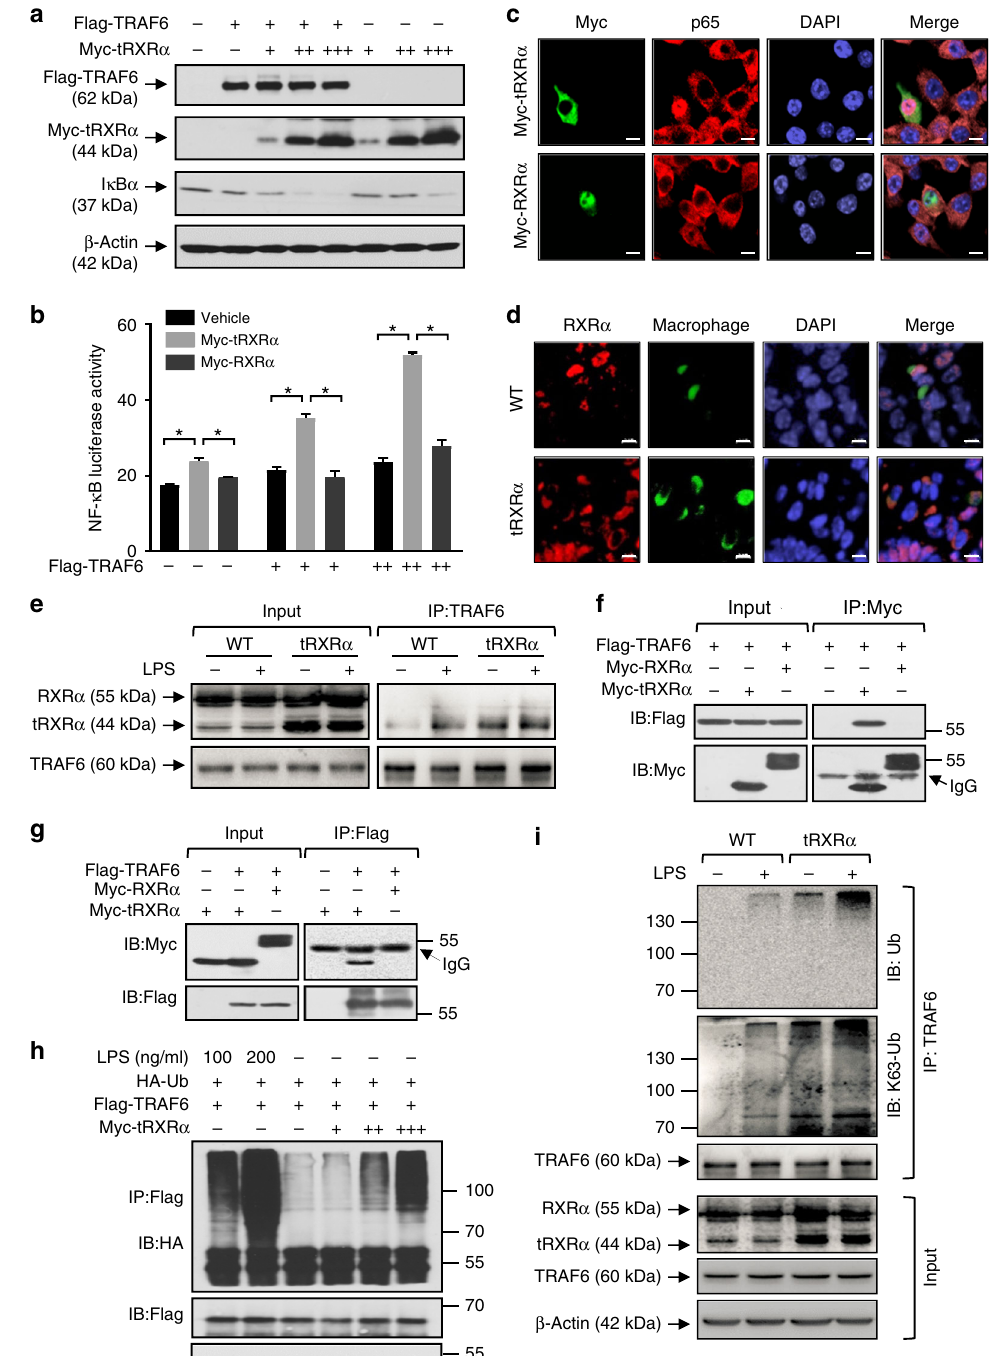
of IL-6 and TNF α (Fig. 5d) and their secretion in medium (Fig. 5e), and the effect of LPS on inducing I κ B α degradation (Fig. 5f) and NF- κ B transactivation (Fig. 5g). Conversely, trans- fection of RXR α small interfering RNA (siRNA) in THP-1 cells, which inhibited the expression of both RXR α and tRXR α , atte- nuated the effect of LPS on inducing I κ B α degradation (Supple- mentary Fig. 4d) and activating the NF- κ B reporter gene transcription (Supplementary Fig. 4e). LPS-induced mRNA expression of IL-6 and TNF α was also inhibited by RXR α siRNA transfection (Supplementary Fig. 4f). Collectively, these results